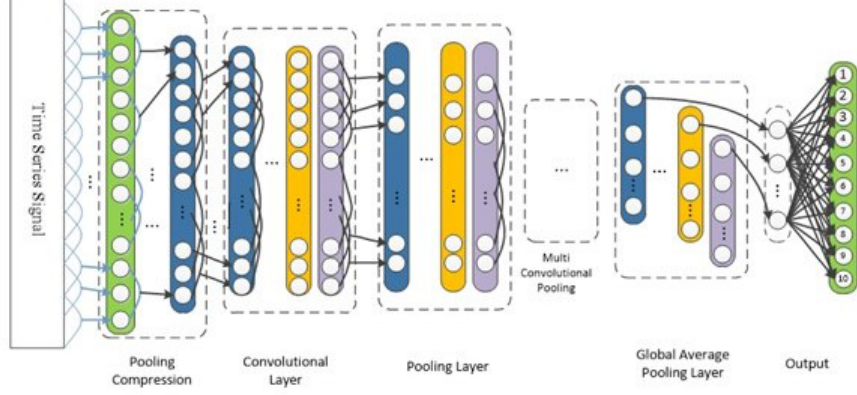
Figure 1. ICECNN-1D Neural Network